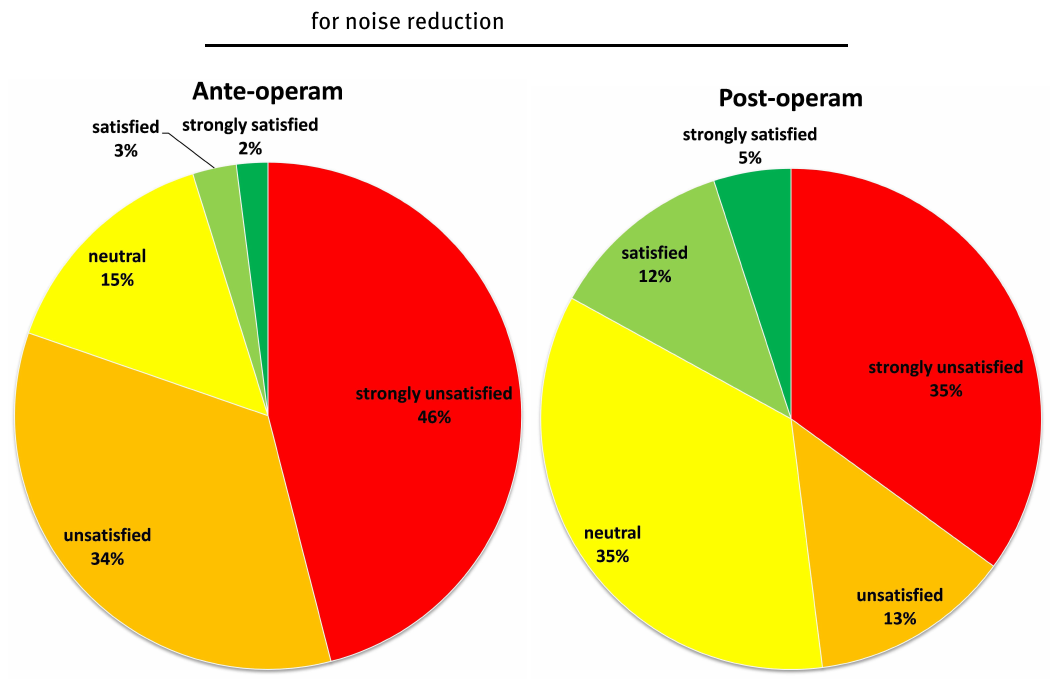
Figure 1: Subjective evaluation of the acoustic satisfaction before and after the realization of an anti-noise measures in Vicenza.